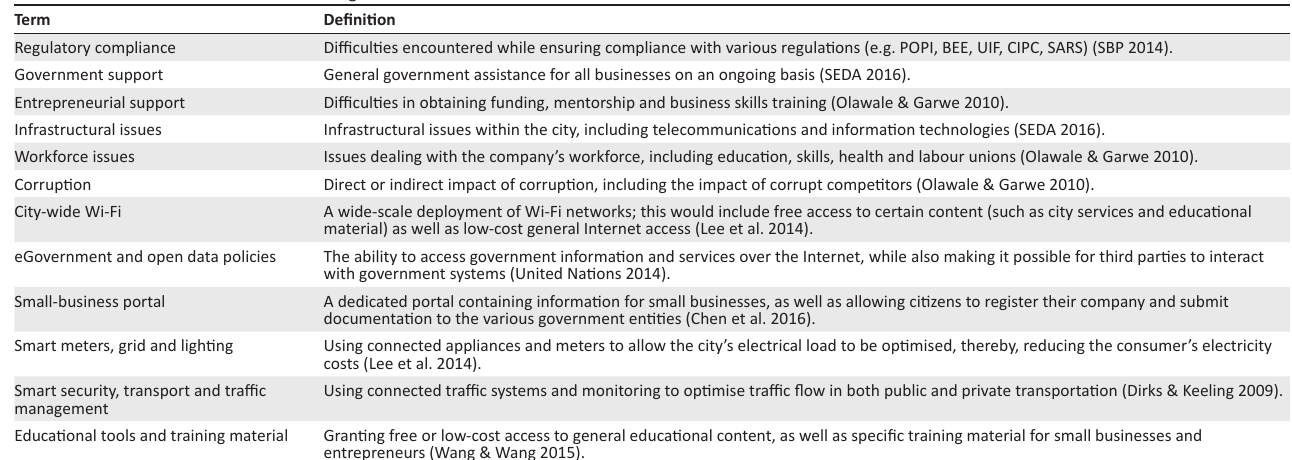
TABLE 1-A1: Definitions of terms used throughout the